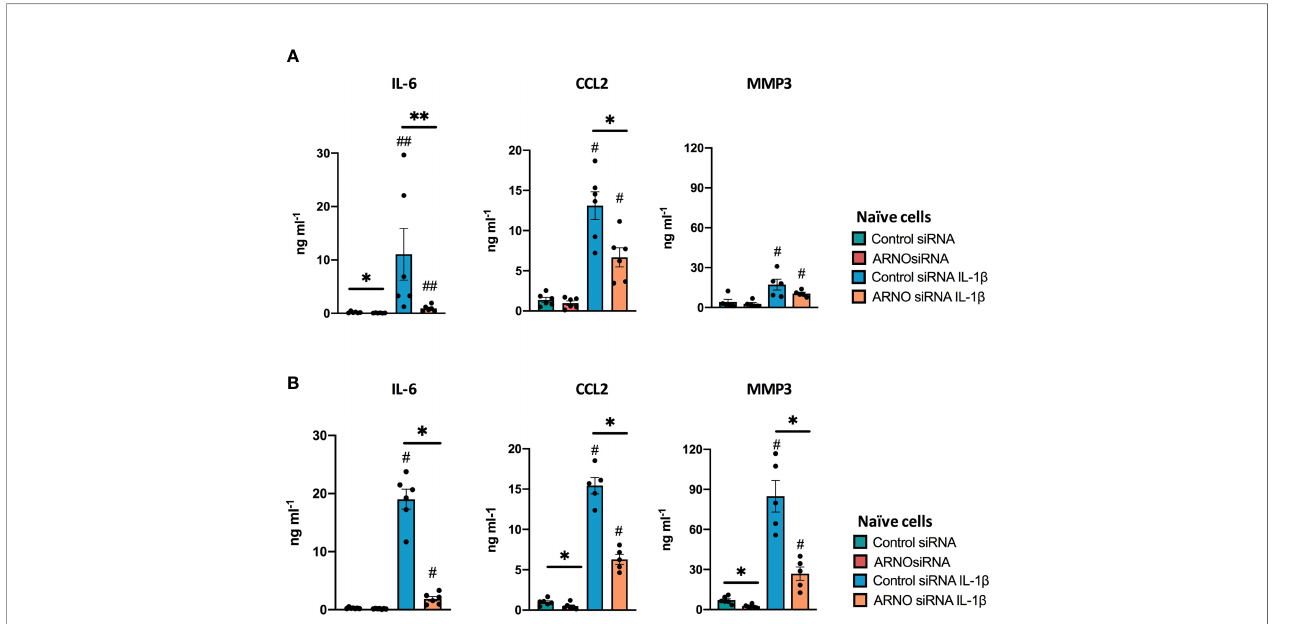
FIGURE 3 | Reduction of ARNO expression down-regulates IL-1 b -mediated cytokine expression. Secretion of IL-6, CCL2 and MMP3 was analysed by ELISA in the supernatant of control and ARNO siRNA treated naïve SFs (A) and SFs expanded from mice undergoing experimental Collagen-Induced Arthritis (B) . Cells were stimulated with IL-1 b as indicated, and cell supernatants were collected after 24h for cytokine quanti fi cation. Each dot represents one independent experiment analysed in triplicate, error bars represent SEM. *p < 0.05, **p < 0.01 versus respective siRNA control; # p < 0.05, ## p < 0.01 versus unstimulated control, Statistical signi fi cance was evaluated by the Mann-Whitney